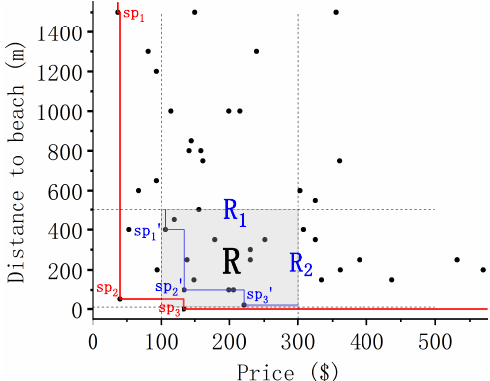
Figure 1. A skyline query based on all hotels and a skyline query based on